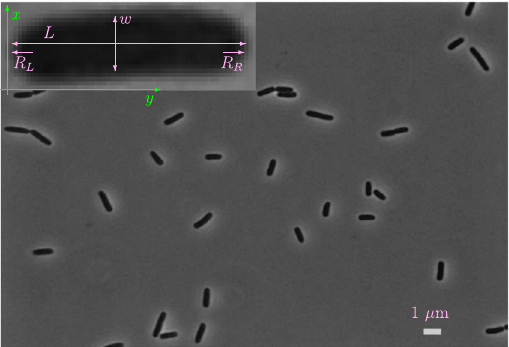
Figure 1. An image of E . coli cells. A typical image of E . coli cells with phase-contrast microscopy. L , w , R L , and R R indicate the length, width, radius of left and right caps of the single-cell in the